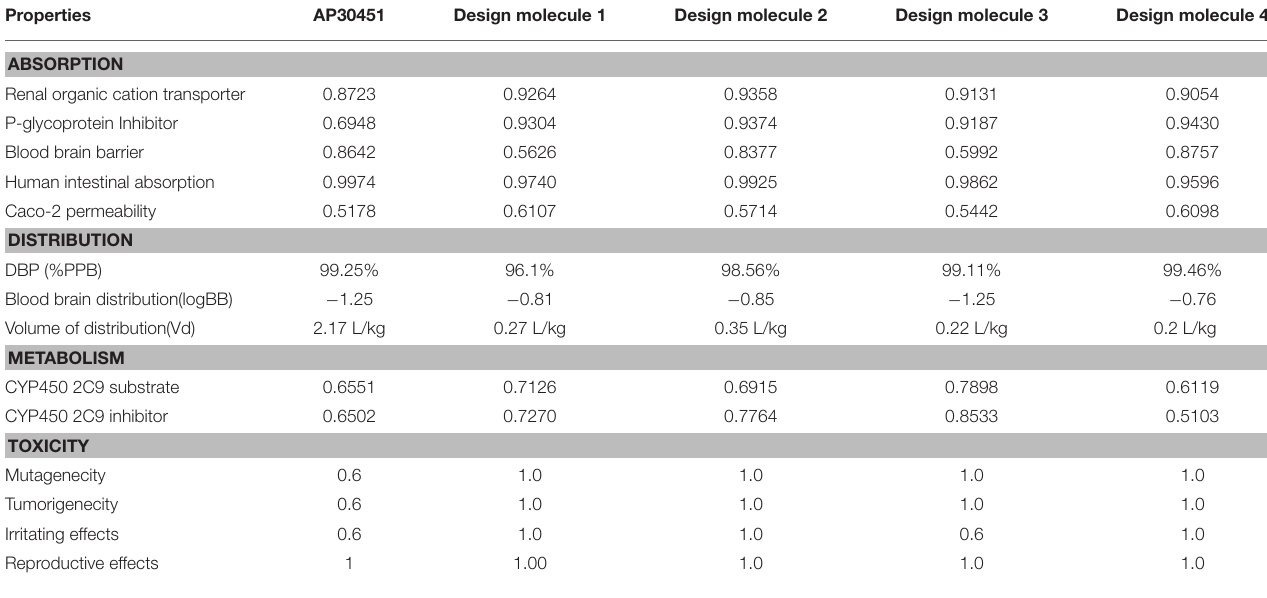
TABLE 5 | ADME properties of designed